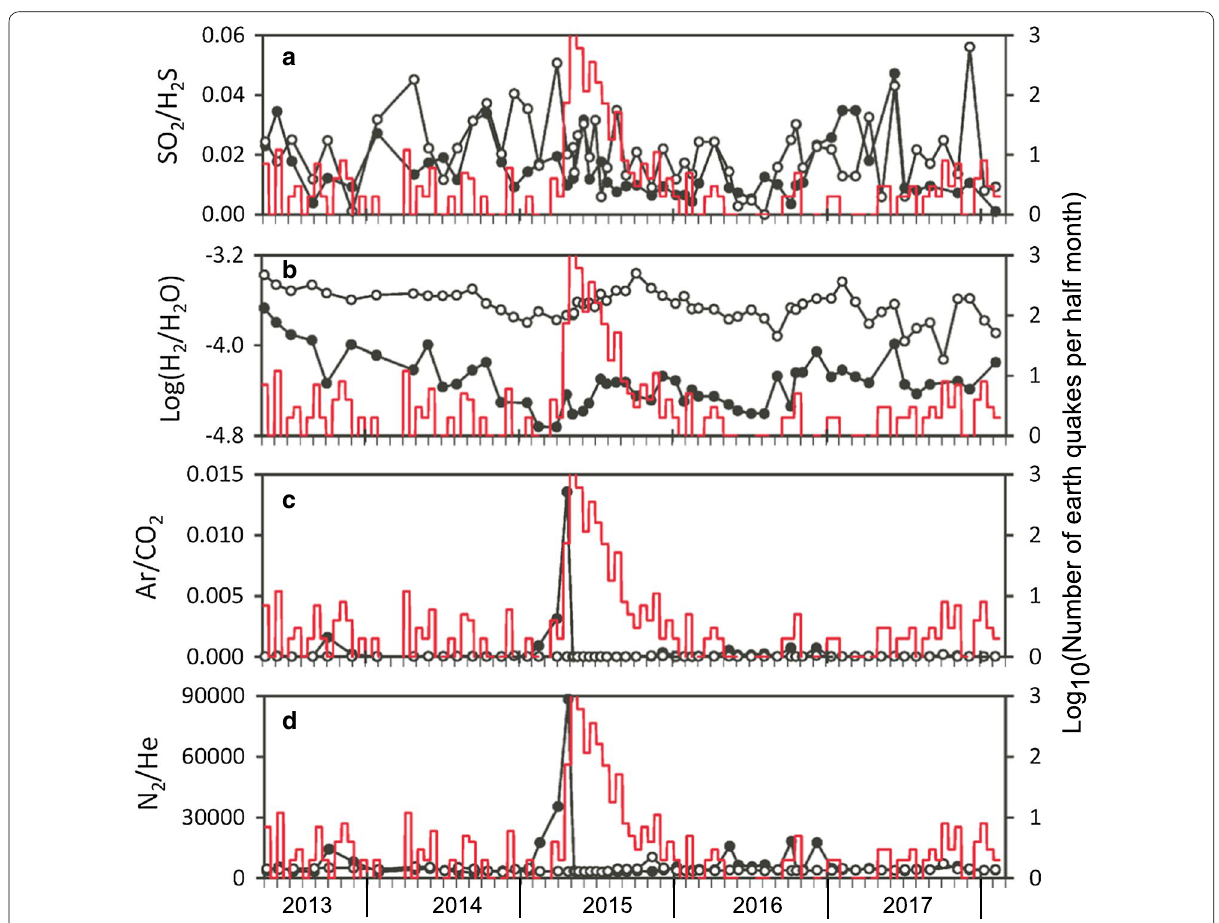
Fig. 3 Time variation of SO 2 /H 2 S, H 2 /H 2 O, Ar/CO 2 , N 2 /He in fumarolic gases. Solid and open circles indicate the values for the fumarole N and S, respectively. Red curve indicates the number of earthquakes per half month observed at Hakone